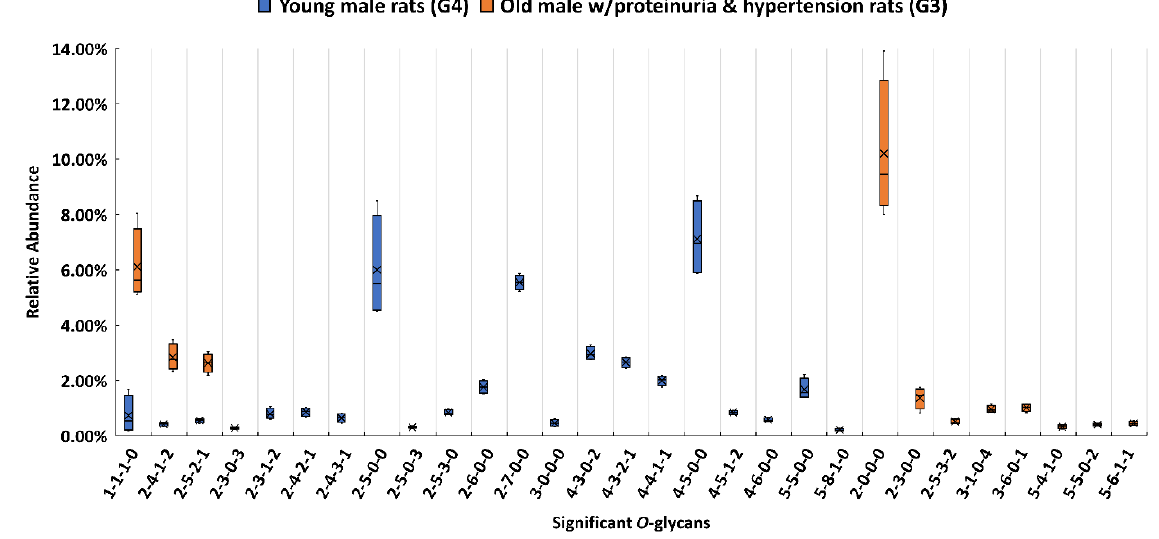
Figure 2. Box plot for the relative abundance of 29 significant O -glycans ( p < 0.001) between young male controls (G4), and older males with proteinuria and hypertension (G3). The putative composition was assigned to each glycan composition. The X axis denotes the four-digit codes for O -glycan compositions. The Y axis is the relative abundance. The error bars are the 95% confidence interval. The four-digit codes represent O -glycan compositions. X-X-X-X stands for HexNAc-Hexose- DeoxyHex-NeuAc. HexNAc includes N -acetylglucosamine and N -acetylgalactosamine. Hexose includes galactose, glucose, and mannose. Deoxyhexose is fucose, and NeuAc is N -acetylneuraminic acid.